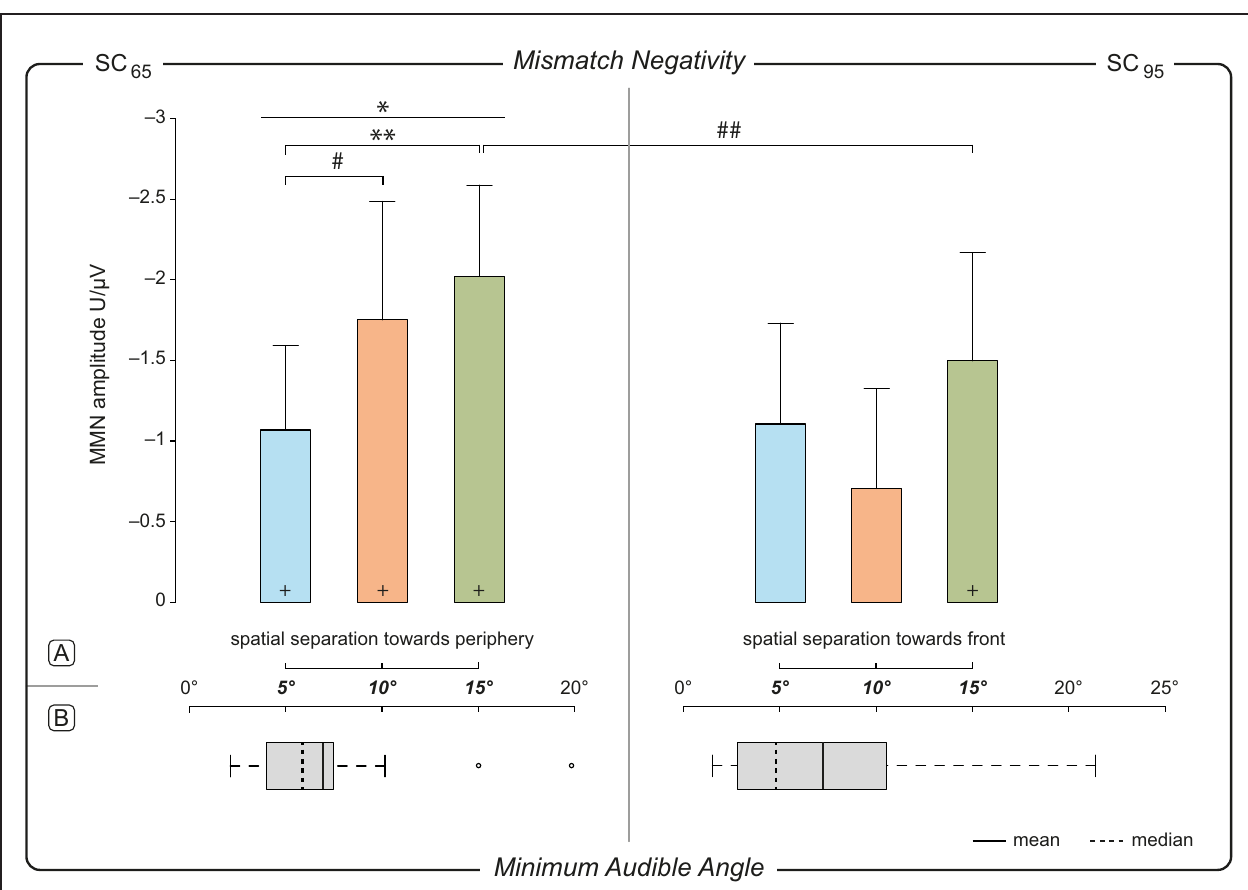
FIGURE 4 | Dependence of MMN amplitude on magnitude of deviation. (A) Mismatch Negativity . Mean individual MMN amplitudes ( n = 17) within a ± 10ms time window around the individual MMN peak amplitude measured at electrode site Fz plotted against the Magnitude of Deviation, MoD, i.e., ± 5 ◦ , ± 10 ◦ , ± 15 ◦ relative to 65 ◦ (left, SC 65 ) and 95 ◦ (right, SC 95 ) std position. Upper limit of 0.95 confidence intervals for the mean values are indicated as error bars. One-Way rm ANVOA revealed a significant MoD -effect on MMN amplitude [ F ( 2 , 32 ) = 5 . 058, p = 0 . 012] in SC 65 . Post-hoc pairwise comparisons revealed higher amplitude for 15 ◦ deviation compared to 5 ◦